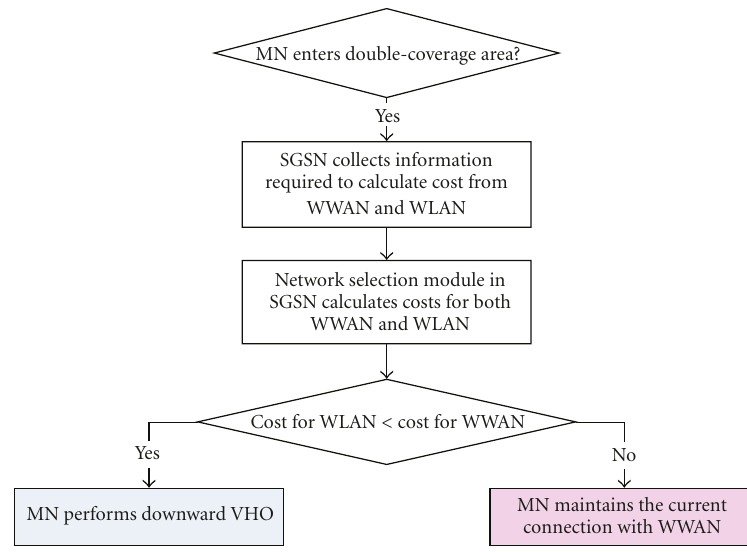
Figure 2: The flow chart of the proposed vertical handover decision